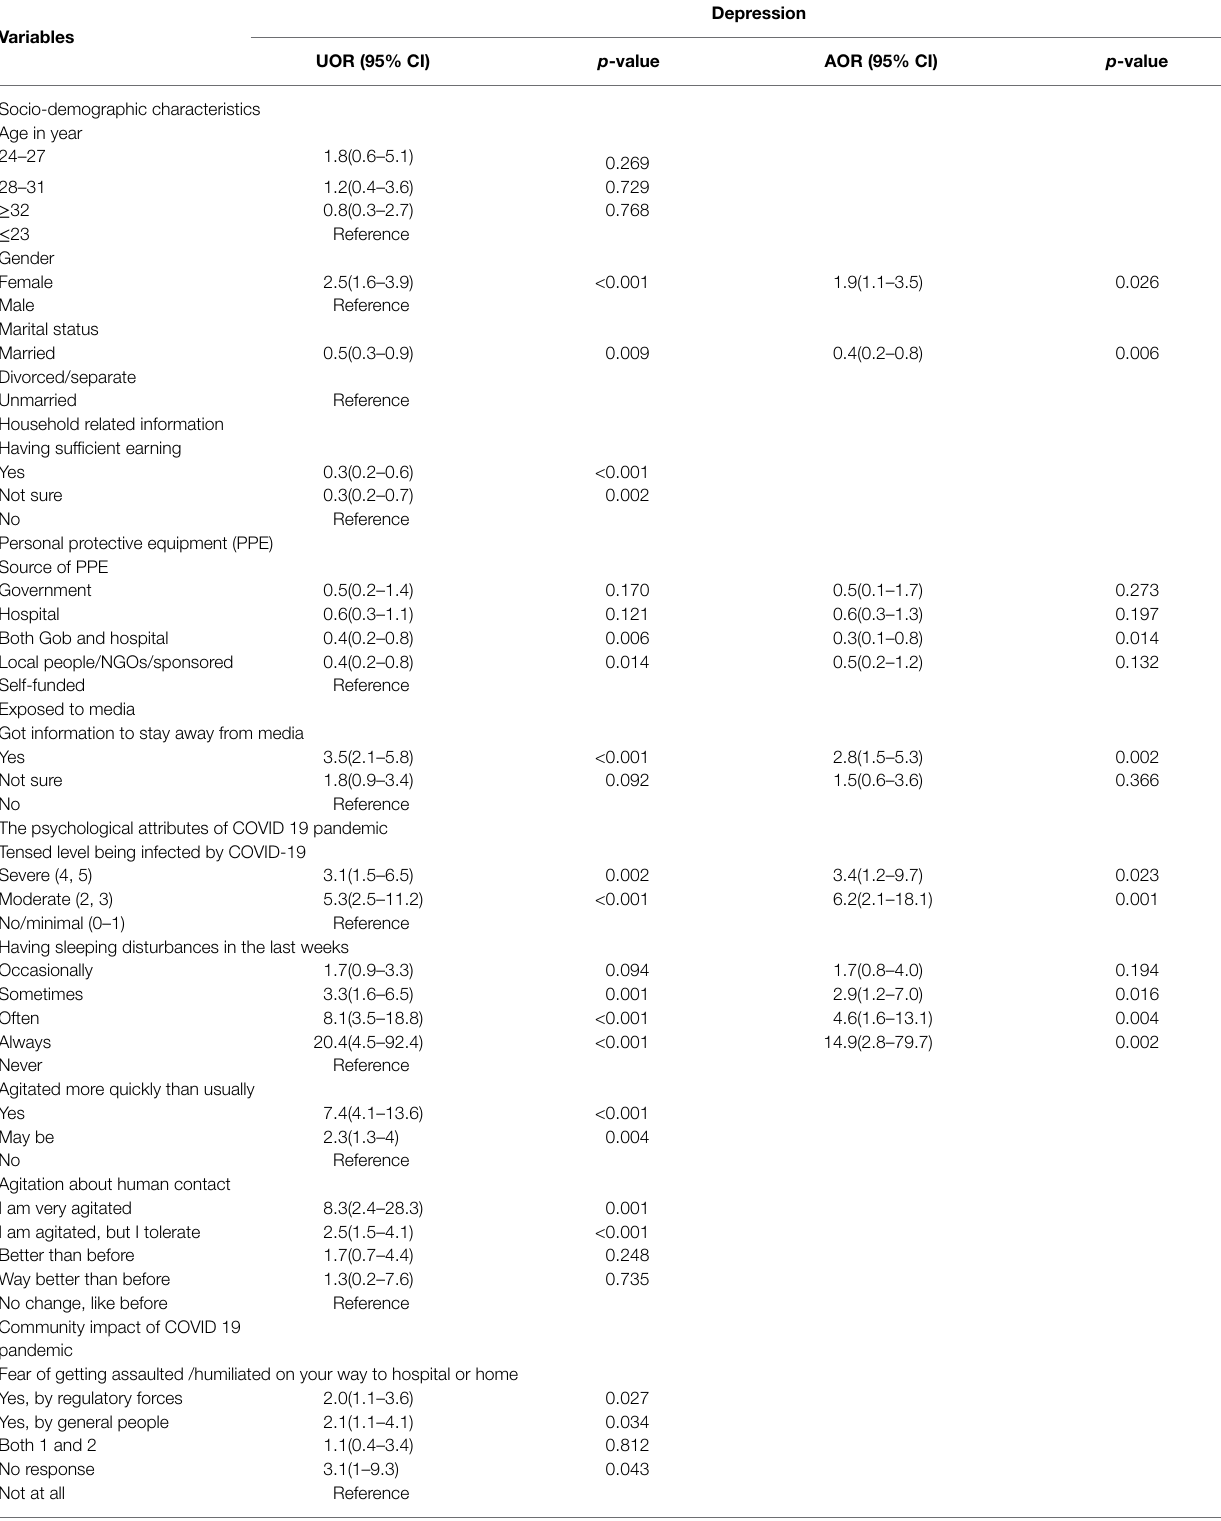
TABLE 2 | Logistic regression analysis of depression measured by PHQ-9 with physicians’ different attributes, 2020 Bangladesh ( N =